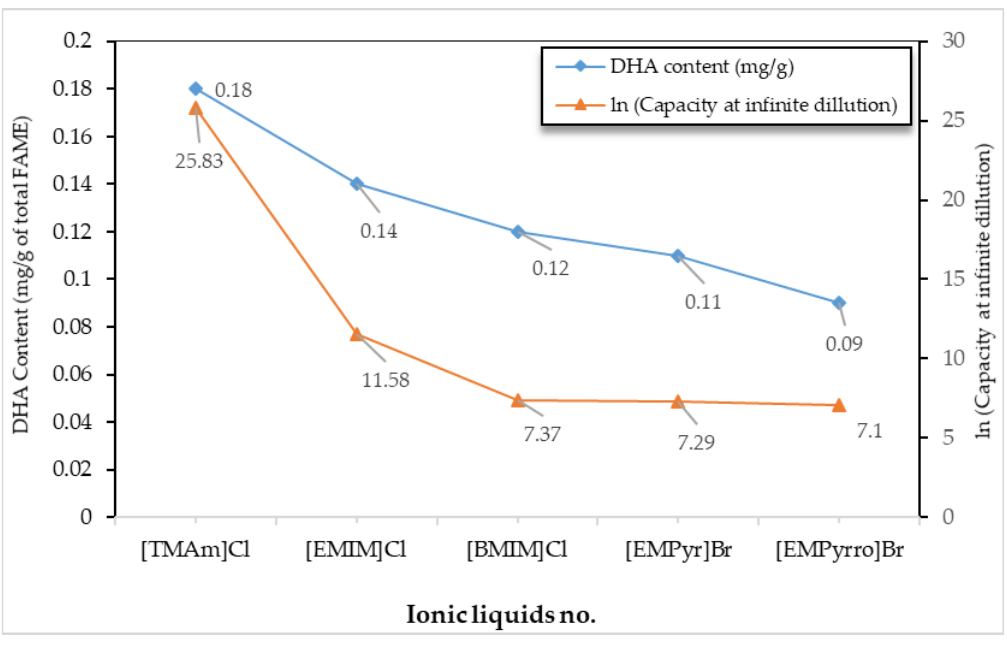
Figure 7. Comparison of the capacity values of selected ILs for the extraction of DHA compounds predicted by COSMO-RS and the experimental DHA extraction yield (mg/g) from Nannochloropsis sp. microalgal.